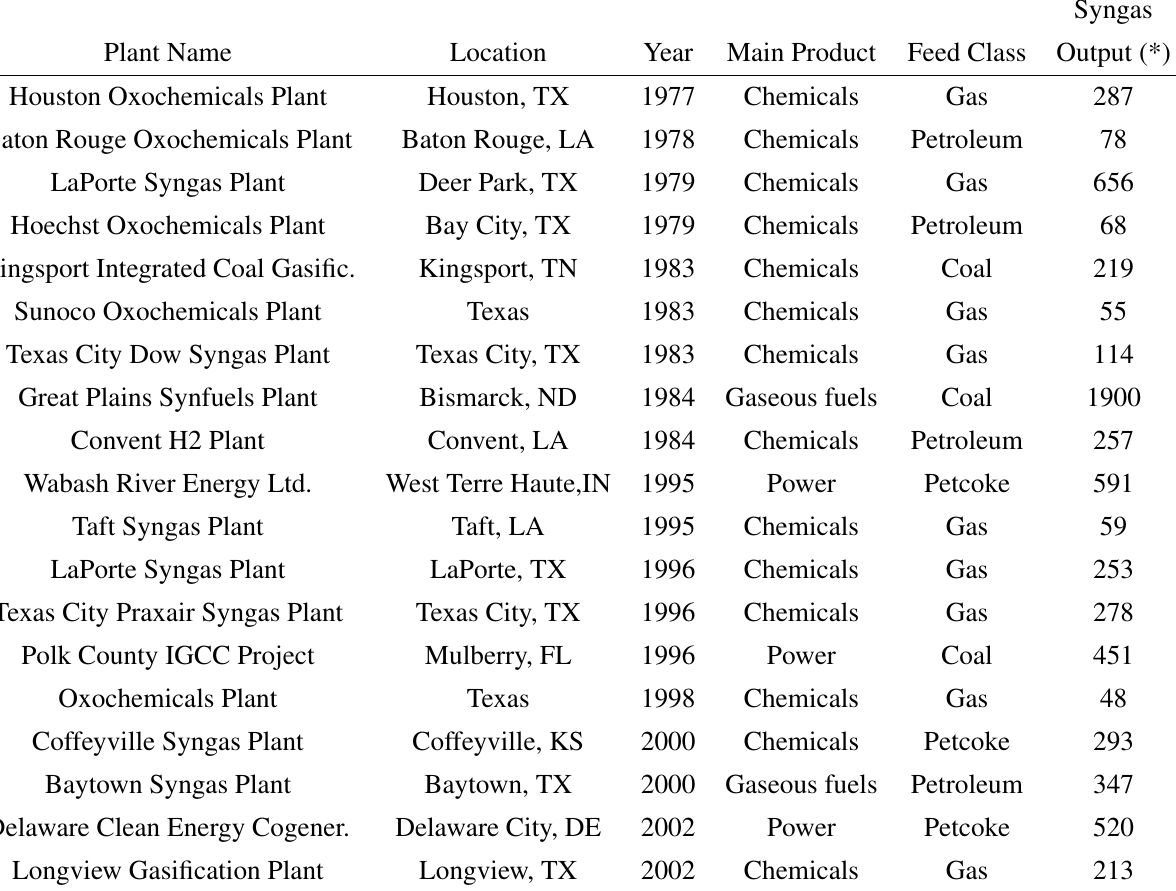
Table 1. Gasification plants in the